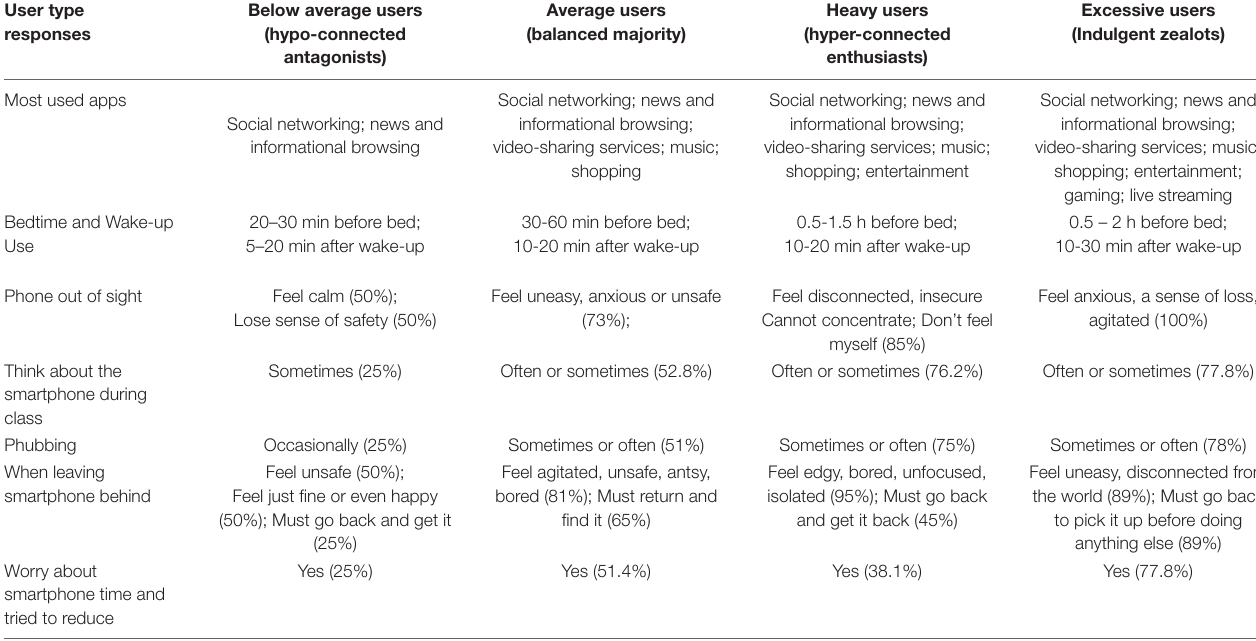
TABLE 2 | Psycho-attitudinal traits of different user